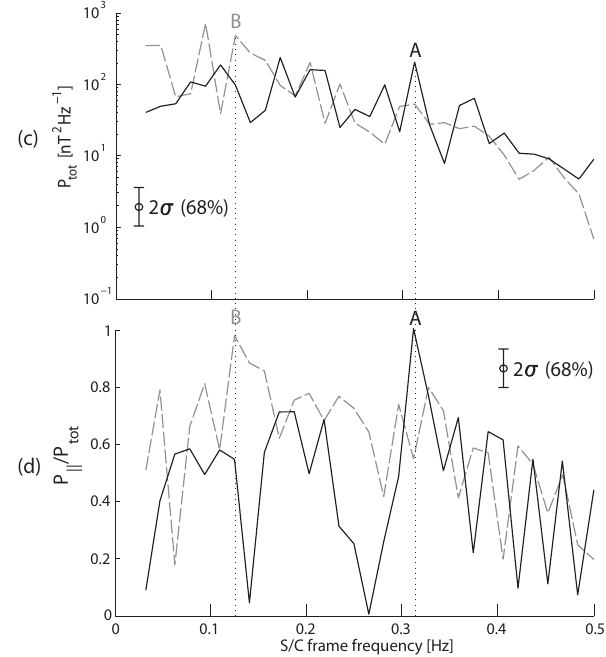
Figure 2. (c) Total power spectral density and (d) ratio between compressional and total poser spectral density for the two time in- tervals (A and B) marked in Fig. 2a and b, based on Venus Express